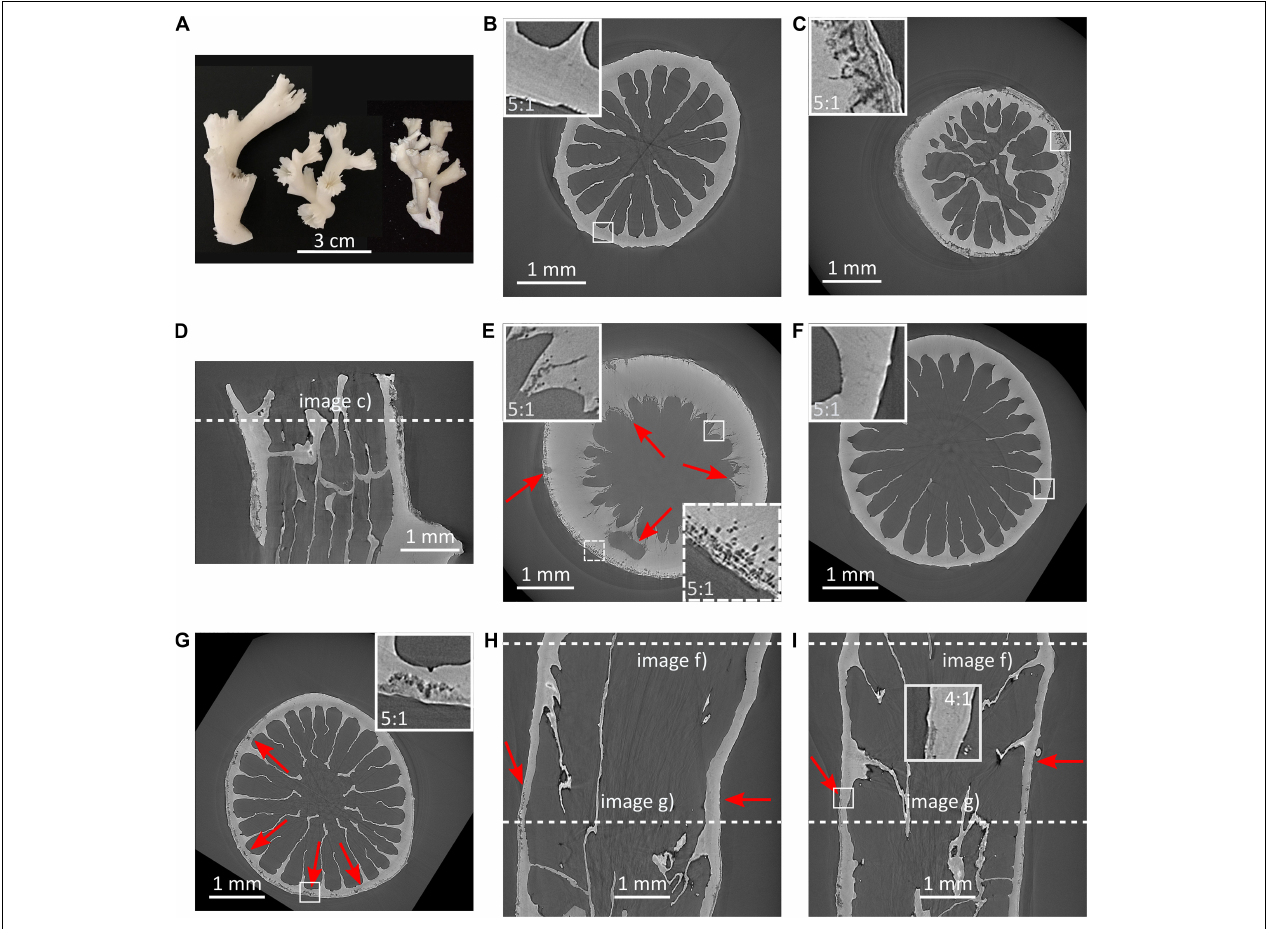
FIGURE 4 | Dissolution and porosity increase in Lophelia pertusa . (A) L. pertusa specimens from the NE Atlantic (left, middle) and the Southern California Bight (right) highlighting morphological variability of this species; (B) transverse SR µ CT cross-section of live coral with protective tissue from below the ASH; (C) transverse SR µ CT cross-section of dead coral without protective tissue from below the ASH, resorption zones are clearly visible at rim including break away patches; (D) longitudinal cross-section of coral in (C) ; (E) transverse SR µ CT cross-section of coral from below ASH showing large porosity from borers and dissolution of internal structures (red arrows skeleton indicating dark pore-areas); (F,G) SR µ CT images showing dissolution in a specimen from below the ASH that was alive and protected by tissue at the top (F) , and exposed skeleton toward the bottom (G–I) , where (I) is a longitudinal cross-section perpendicular to (H) . Red arrows indicate onset of porosity in (H,I)